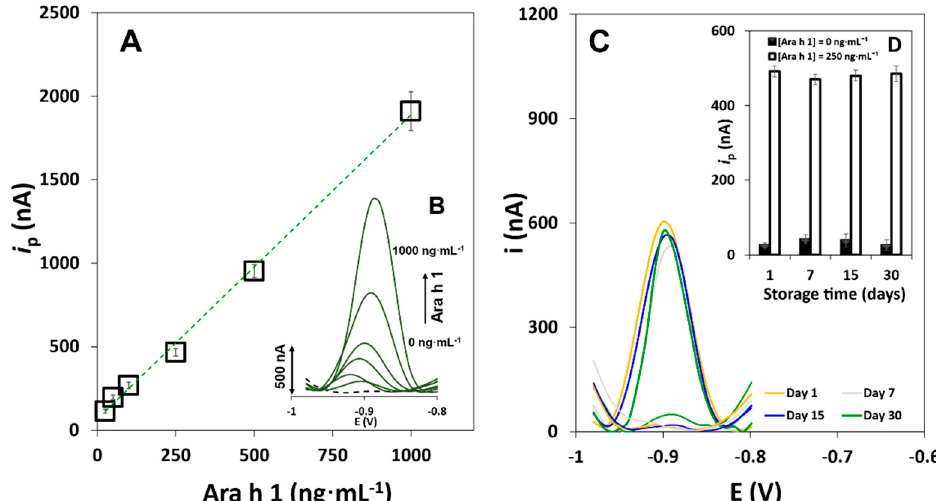
Figure 4. Analysis of Ara h 1. ( A ) Calibration straight; ( B ) Representative DPASV voltammograms ([Ara h 1] (ng · mL − 1 ): 0, 25, 50, 100, 250, 500, and 1000). (error bars correspond to the standard deviation of 3 replicates). ( C ) Examples of DPASV voltammograms obtained in the stability study; ( D ) obtained i p values in the stability study (day 1 (control), 7, 15 and 30). Experimental conditions: CAb 10 µg·mL − 1 , Ara h 1 (0 and 250 ng·mL − 1 ), DAb (250× dilution in Tris-BSA 1.0% (m/V)), QD-strep 5.0 nM + BSA 2.0% (m/V).